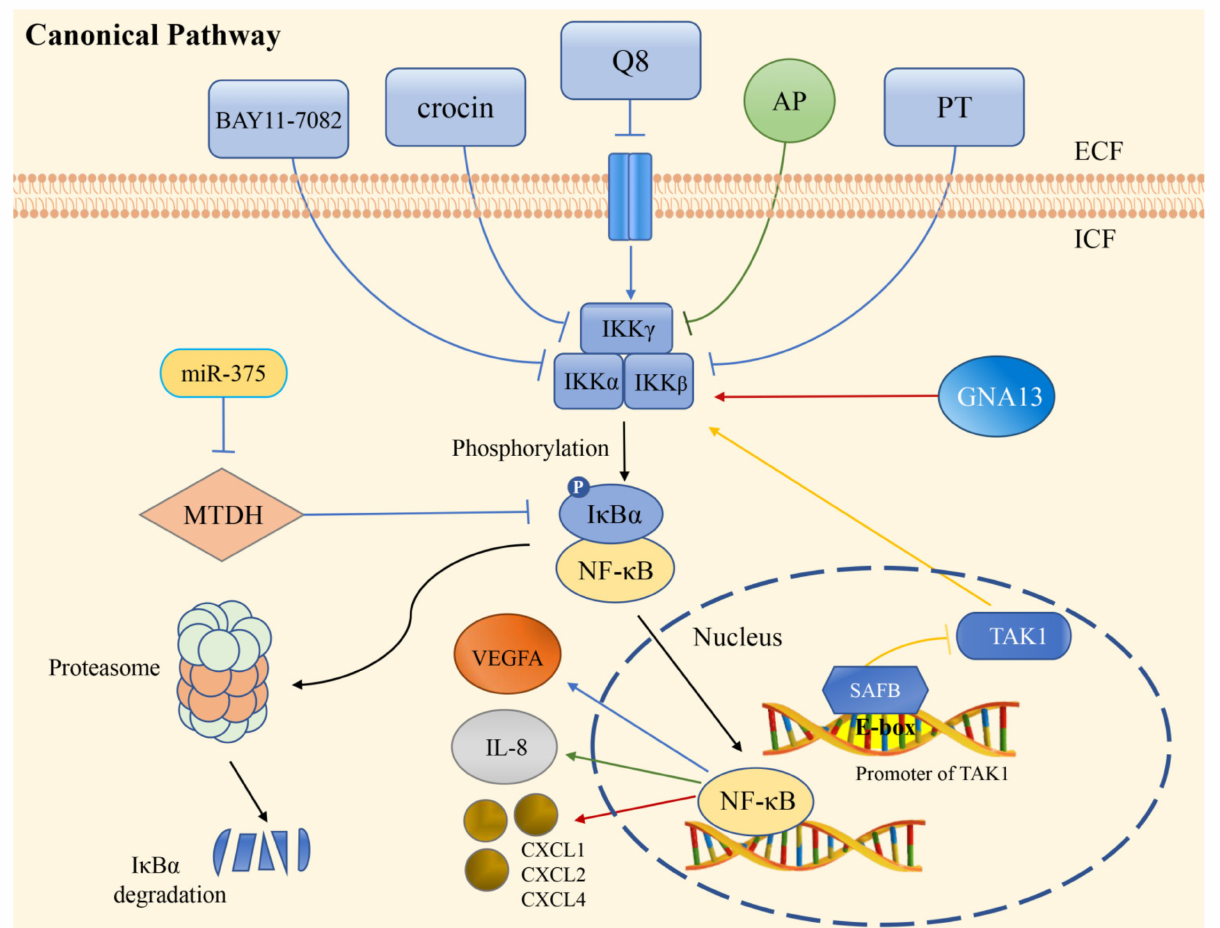
Figure 2. Regulation of angiogenesis via the canonical NF- κ B pathway in CRC. The extracellular compounds BAY11-7082, crocin, Q8, and PT inhibit the expression of VEGFA by suppressing the phosphorylation of I κ B. While GNA13 promotes angiogenesis through the regulation of chemokines production. AP restrains IL-8 production and angiogenesis by inhibiting the degradation of I κ B, then prevents NF- κ B from entering the nucleus. SAFB targets the promoter of TAK1 in the nucleus and inhibits angiogenesis. The expression of miR-375 can downregulate MTDH level, leading to the inhibitory effect of I κ B α on NF- κ B. Q8: IUPAC name (E)-2-(2-quinolin-2-yl-vinyl)-benzene-1,4-diol HCl; AP: Andrographolide; PT: Parthenolide; IKK: I κ B kinase complex; SAFB: scaffold attachment factor B; MTDH: